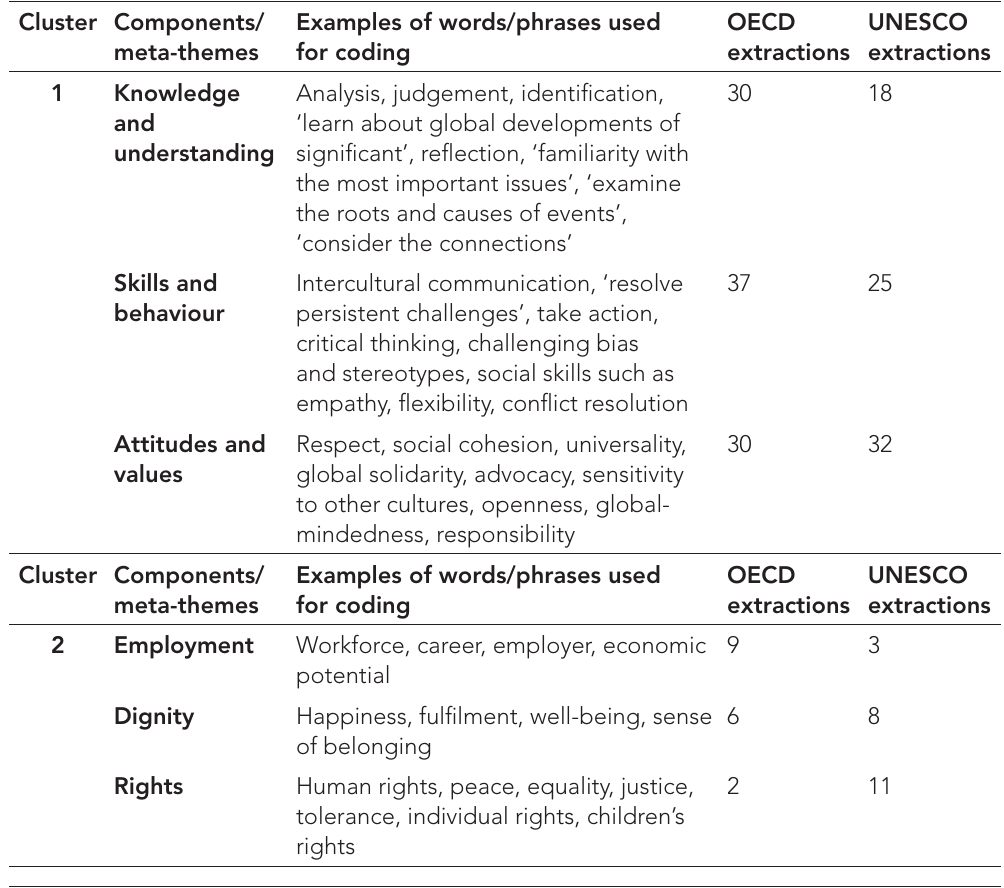
Table 2: Thematic coding results Cluster